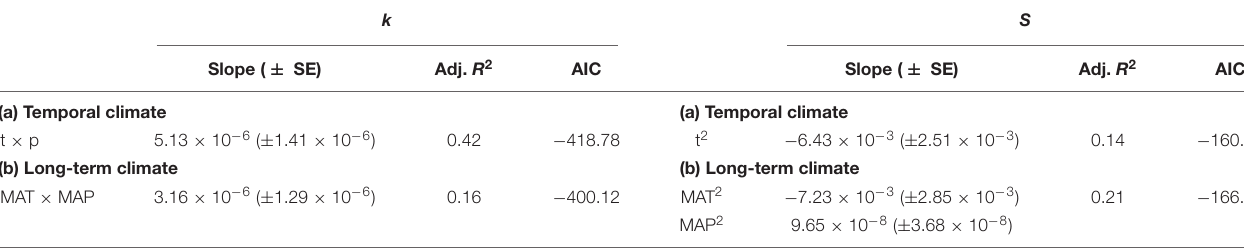
TABLE 3 | Selected regression models for the temporal and long-term climate models.